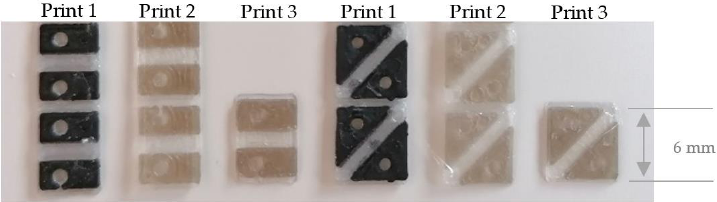
Figure 15. 3D printed single-layer LED sequins and sequin tapes with different print cores and